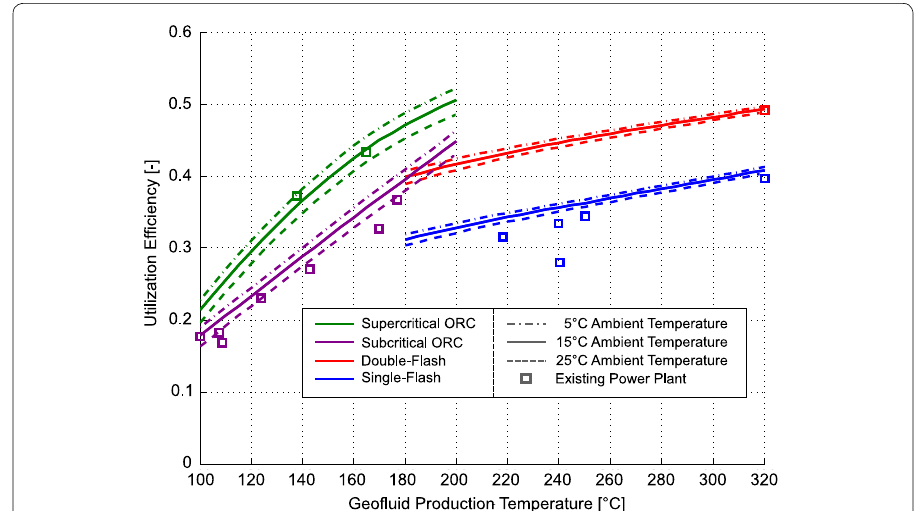
Fig. 2 GEOPHIRES built-in utilization efficiency correlations for ORC (subcritical and supercritical) and flash (single and double) power plants. Correlations provide power plant utilization efficiency as a function of production and ambient